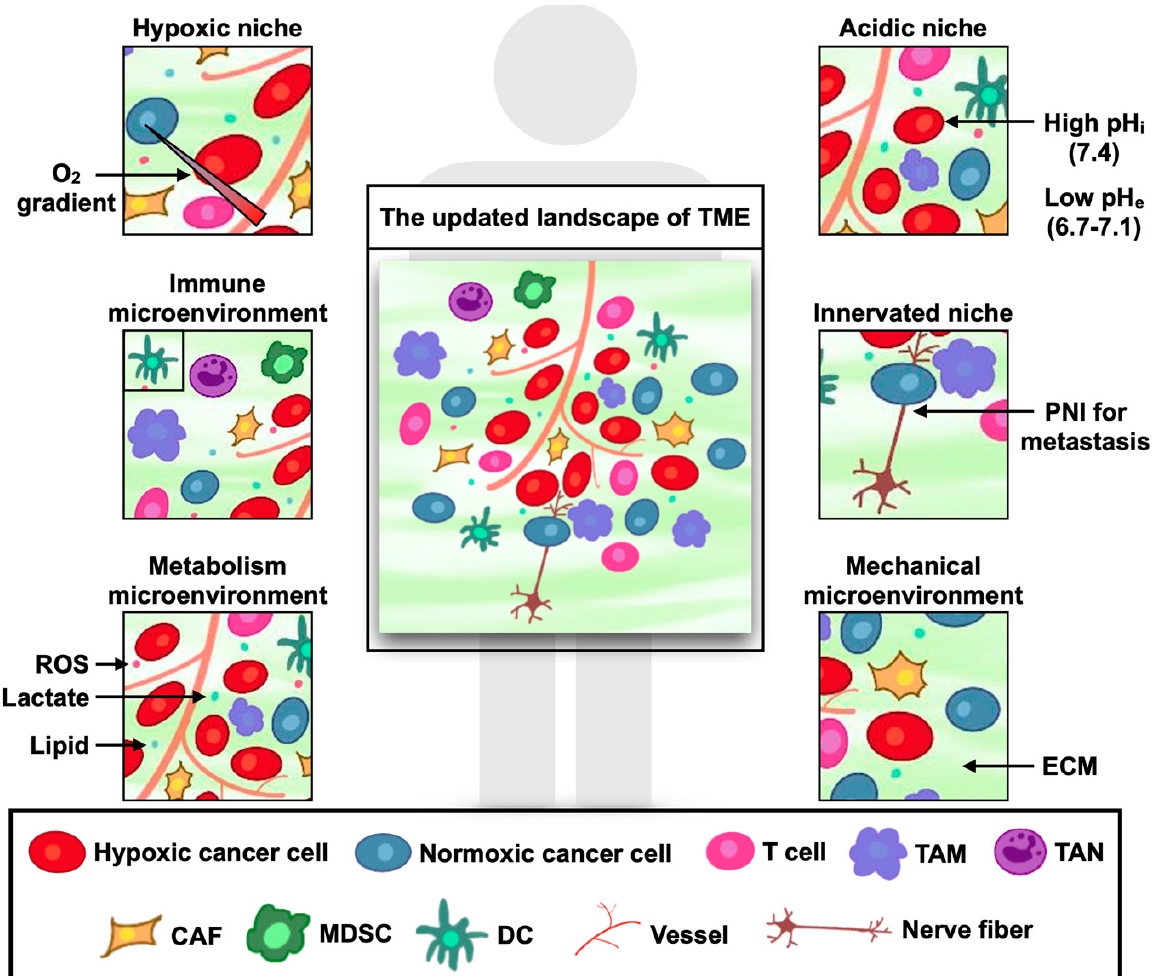
Figure 1. The updated landscape of tumor microenvironment (TME). Reprinted from an open-access source [46]. Abbreviations: CAF—cancer-associated fibroblasts; DC—dendritic cells; ECM— extracellular matrix; MDSC—myeloid-derived suppressor cells; PNI—perineural invasion; ROS— reactive oxygen species TAM—tumor-associated macrophages; TAN—tumor-associated neutrophils.